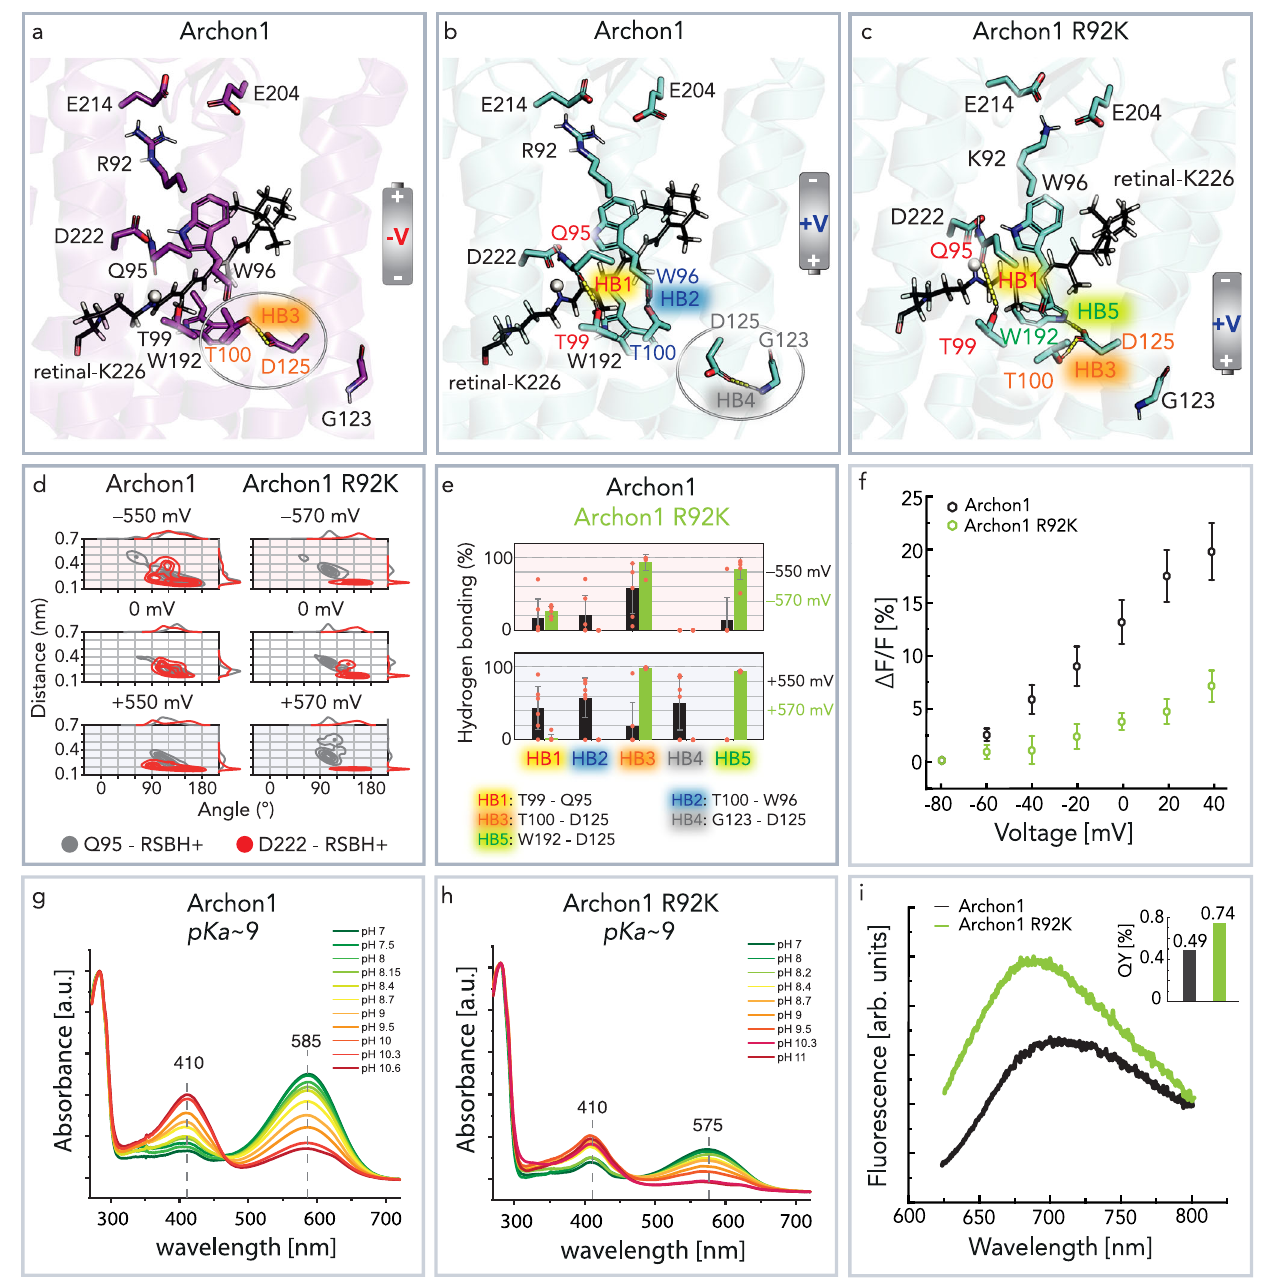
Fig. 3 | Voltage sensing in Archon1. a , b Voltage-induced conformations of Archon1 as predicted by MD simulations. a At negative voltage, the key residue D125 interacts with T100by hydrogenbonding (HB3). b This contactbreaks atthe positive voltage and D125 fl ips towards intracellular G123 (HB4). The voltage- induced side-chain reorientation strongly affects the complete hydrogen bonding network (from HB1 to HB4) around the retinal (retinal: black stick representation; Schiffbaseproton:whitesphere). c HydrogenbondingnetworkasobservedbyMD simulations ata positive transmembrane voltage in Archon1-R92K. d Distanceand angle distributions between the RSBH + and the two counterions Q95 (gray) and D222 (red) as observed by MD simulations at positive, zero, or negative trans- membrane voltage in Archon1 and Archon1-R92K. e Probability of key hydrogen bonds in Archon1-R92K (green) compared to Archon1 (black) at positive, zero, or negativetransmembranevoltage(thenumberofsimulationsforeachvoltage=6). Alllistedhydrogenbondsareestablishedbetweenthesidechains.OnlyW96-T100